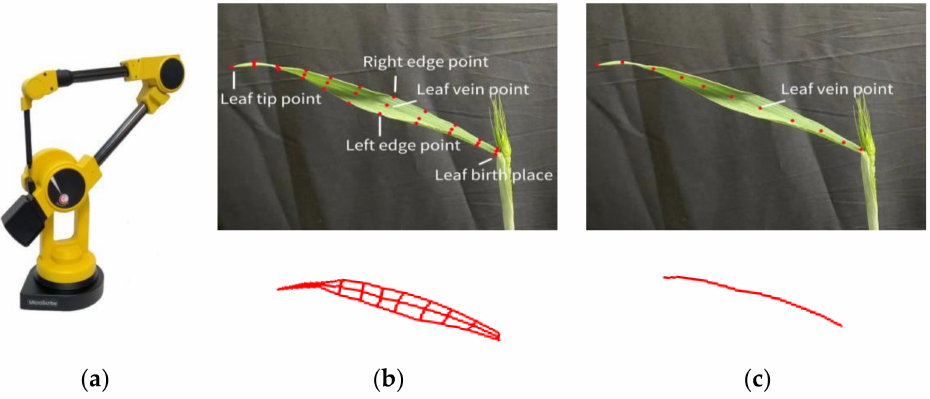
Figure 1. ( a ) The 3D digital data acquisition instrument; ( b ) The specific data captured; ( c ) The extracted leaf